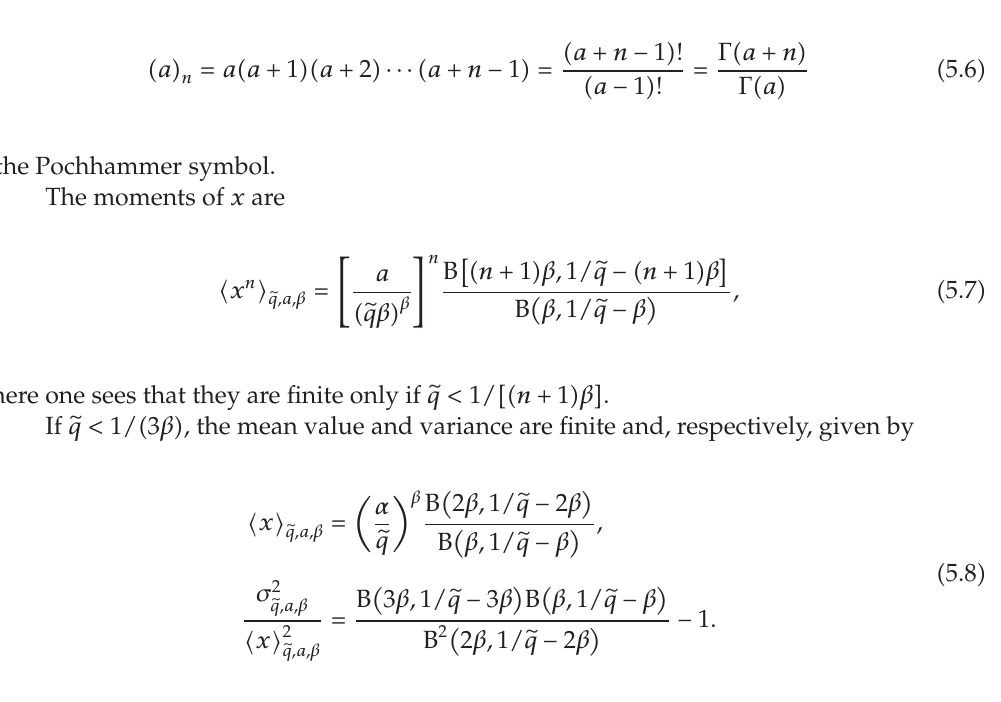
(cid:7) a (cid:2) a (cid:8) 1 (cid:3)(cid:2) a (cid:8) 2 (cid:3) · · · (cid:2) a (cid:8) n − 1 (cid:3) (cid:7) (cid:2) a (cid:3) n